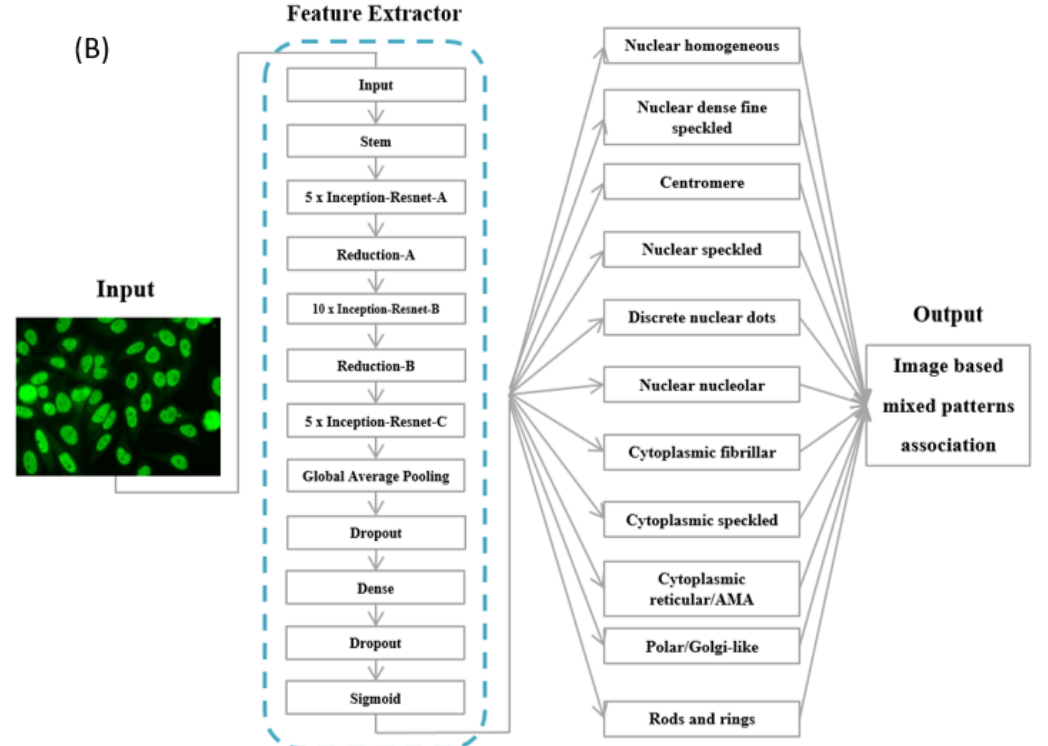
Figure 3. ( A ) Schematic depiction of dataset in this study for training phase and evaluation phase. ( B ) The overall convolutional neural network (CNN) architecture of the proposed model (InceptionResNet V2) for ANA mixed patterns classification. TCVGH = Taichung Veterans General Hospital; CNN = convolutional neural network; IOA = inter-observation agreement; * among five experienced-certified medical technologists, two new rheumatology fellows-in-training and the proposed model.